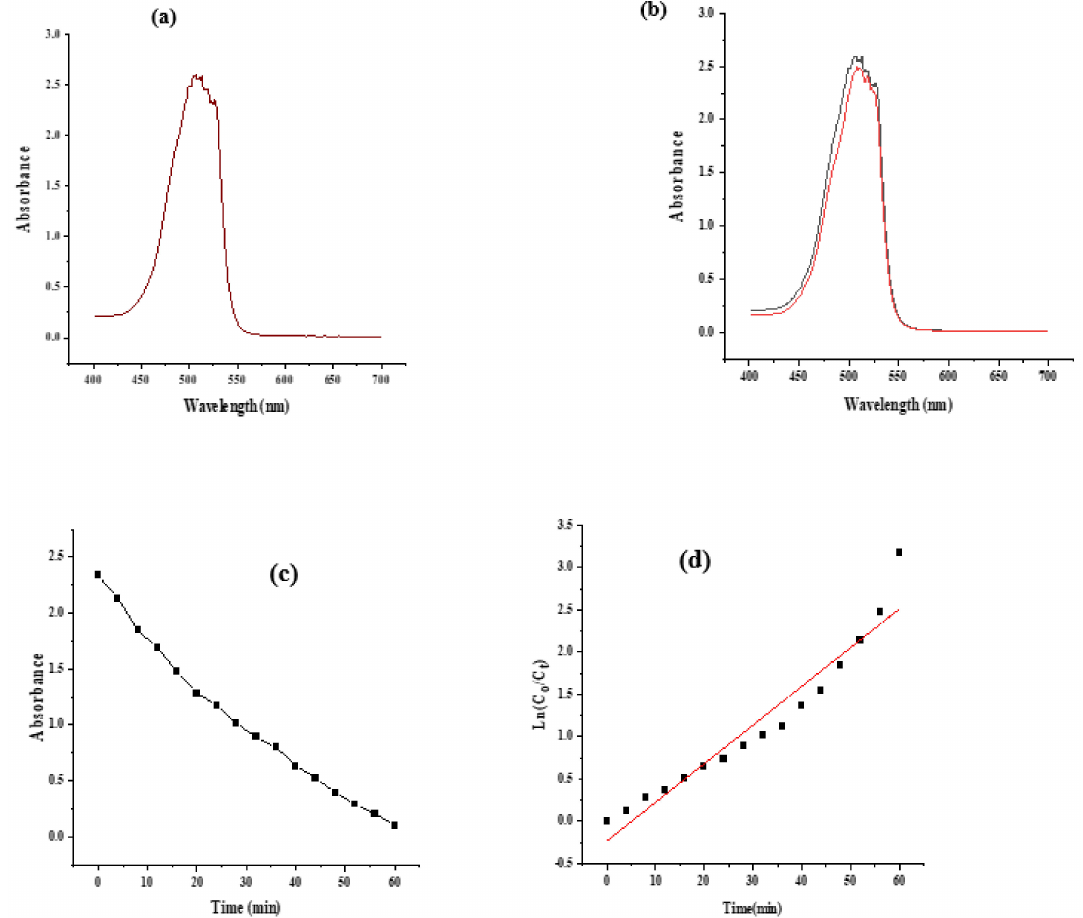
Figure 19. UV-Vis spectra of Eosin Y solution ( a ), UV-Vis spectra of Eosin Y after treating it with NaBH 4 ( b ), degradation trend of EY dye after addition of silver nanoparticles solution ( c ), time- dependent kinetically plotted graph ( d